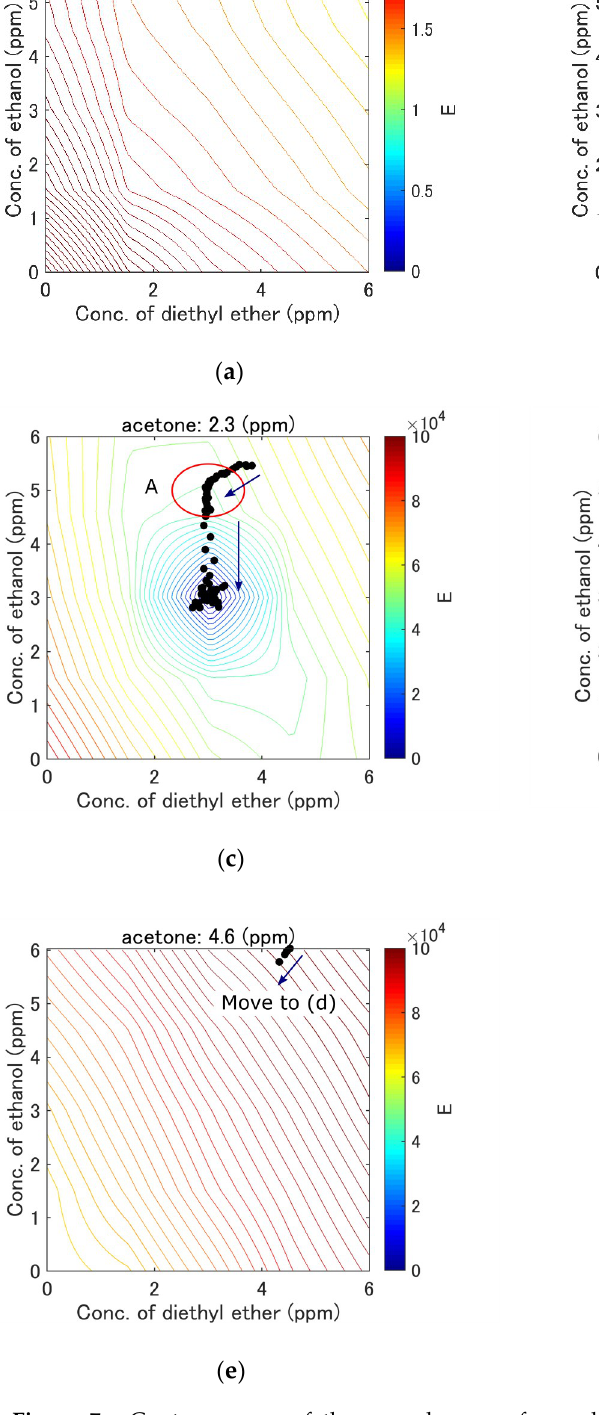
Figure 7. Contour maps of the error hypersurfaces obtained from all the measurement data. The concentration of acetone was fixed to prepare the contour maps. ( a ) 0 ppm, ( b ) 1.2 ppm, ( c ) 2.3 ppm, ( d ) 3.5 ppm, ( e ) 4.6 ppm. Black points mean the update point